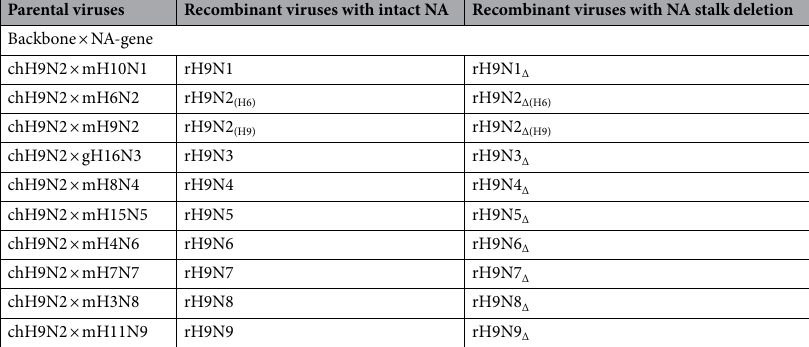
Table 2. List of generated recombinant rH9Nx viruses with and without stalk deletion. Letters m = mallard and g = black-headed gull denotes the host origin. All recombinant viruses have a gene backbone derived from the chH9N2 (PB2, PB1, PA, HA, NP, NS and M) together with a wild bird derived NA-gene.